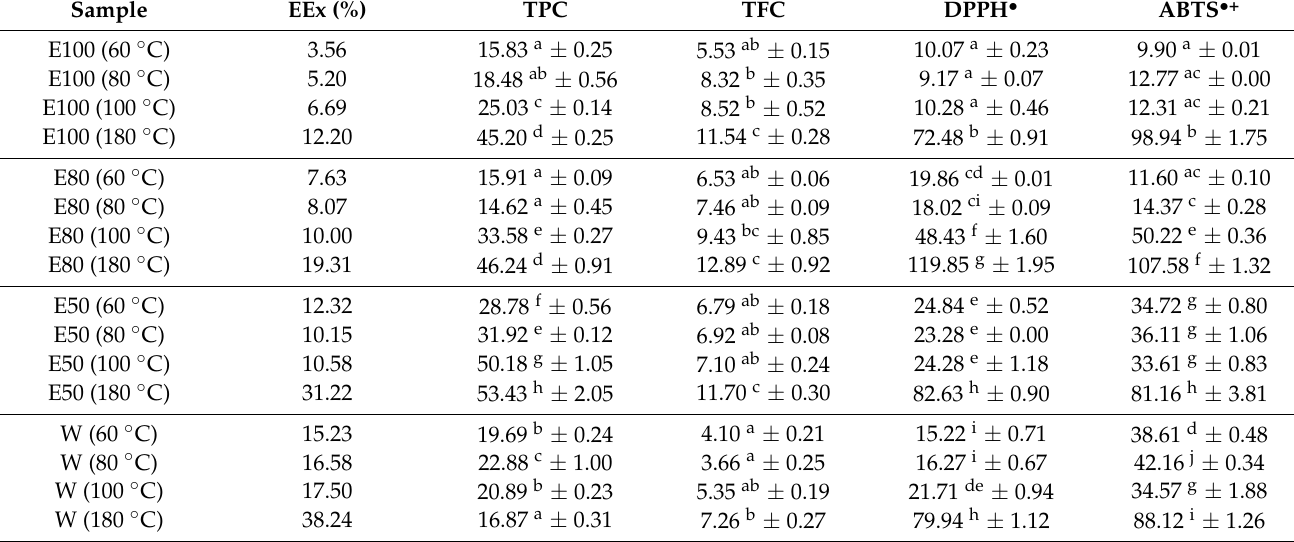
Table 1. Efficiency of extraction (EEx), total phenolic content (TPC), total flavonoid content (TFC), and antioxidant activity assessed with the DPPH • and ABTS • + methods in extracts obtained from Aerva lanata (L.) Juss. herb. Explanations: EEx—calculated per dry extract obtained from 1 g of